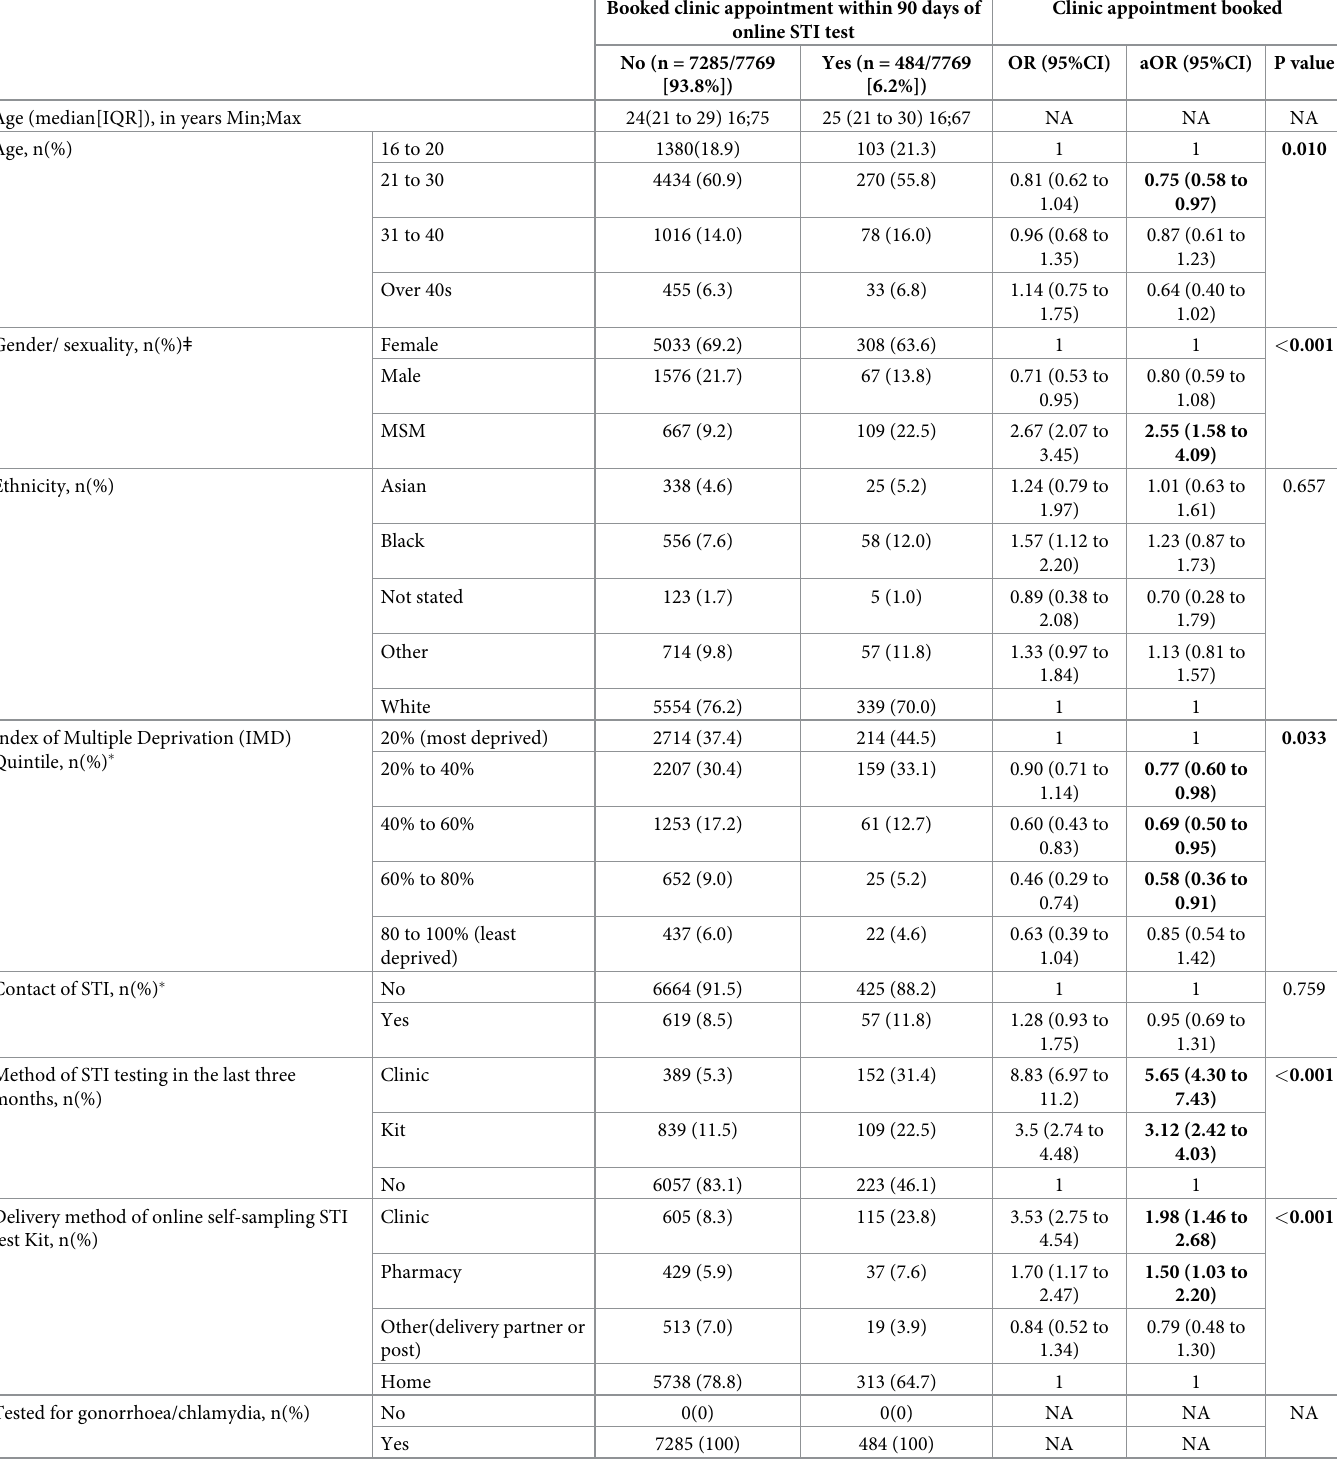
Table 3. Factors associated with booking a sexual health clinic appointment within 90 days of an asymptomatic online STI test (n = 7769).